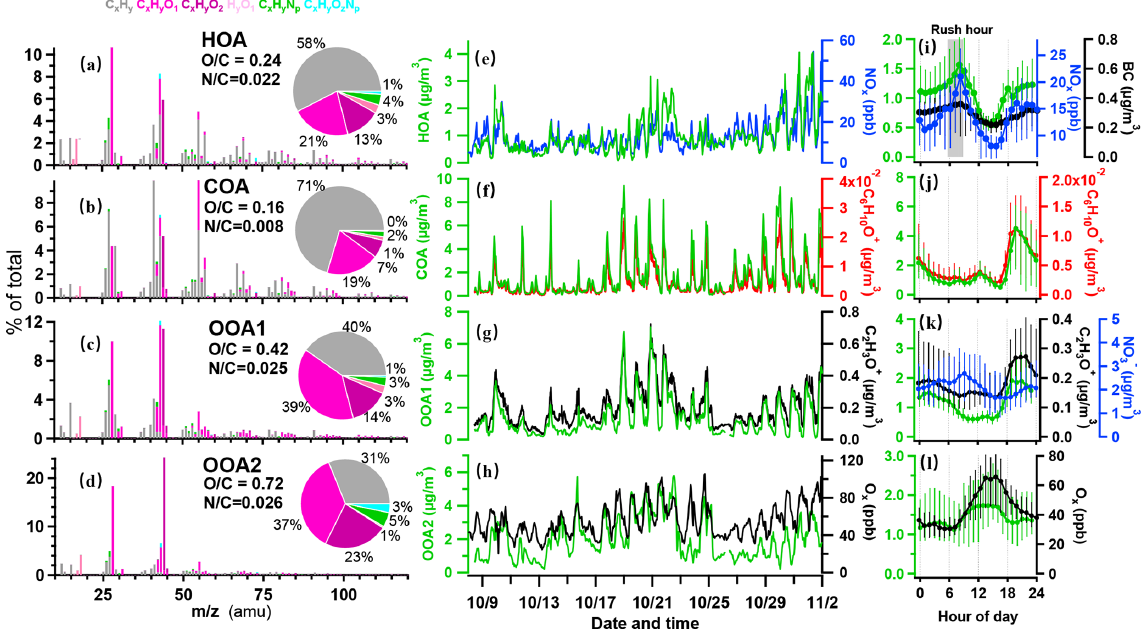
Figure 2. Results of source-attributed organic aerosols by the PMF analysis on the OA mass spectra measured by the HR-ToF-AMS. Mass spectra of PMF factors for (a) hydrocarbon-like OA (HOA), (b) cooking OA (COA), (c) oxygenated OA1 (OOA1), and (d) oxygenated OA2 (OOA2). The pie charts show the relative contributions of the six ion categories to each factor. (e–h) Temporal variations in four OA factors (HOA, COA, OOA1, and OOA2), with each correlated species as NO x , C 6 H 10 O + , C 2 H 3 O + , and O x . (i–l) Diurnal profiles of NO x , BC, C 6 H 10 O + , C 2 H 3 O + , NO − , and O x . The lines and whiskers denote the median, the 25th, and the 75th percentiles at each hour, 3